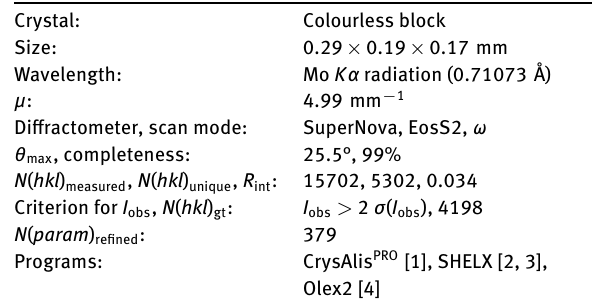
Table 1: Data collection and